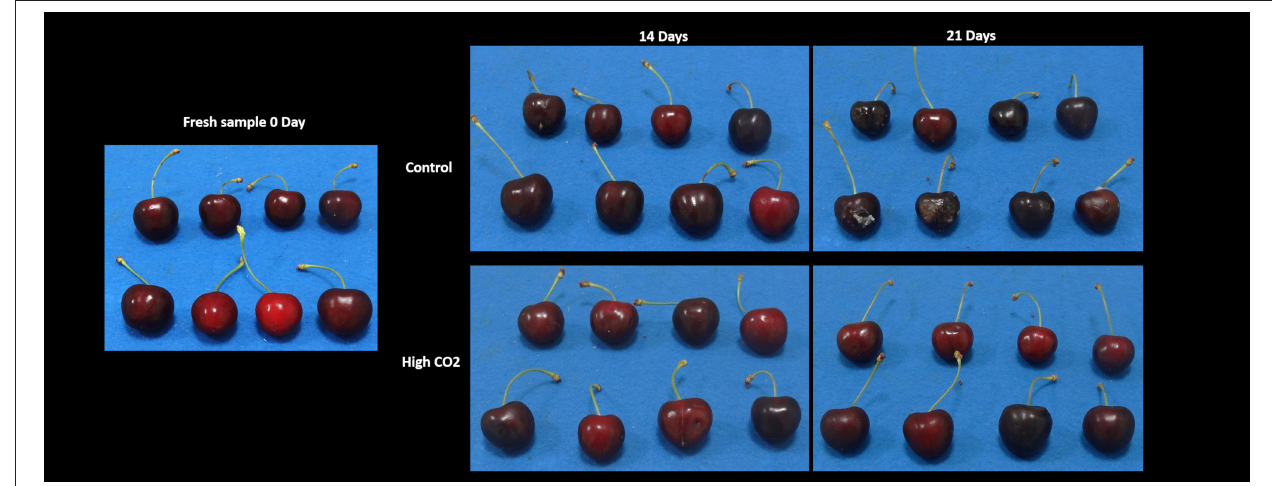
FIGURE 1 | The visual appearance of sweet cherries at harvest and stored in high-CO 2 or the air (control) after 14 and 21 days at 5 ◦